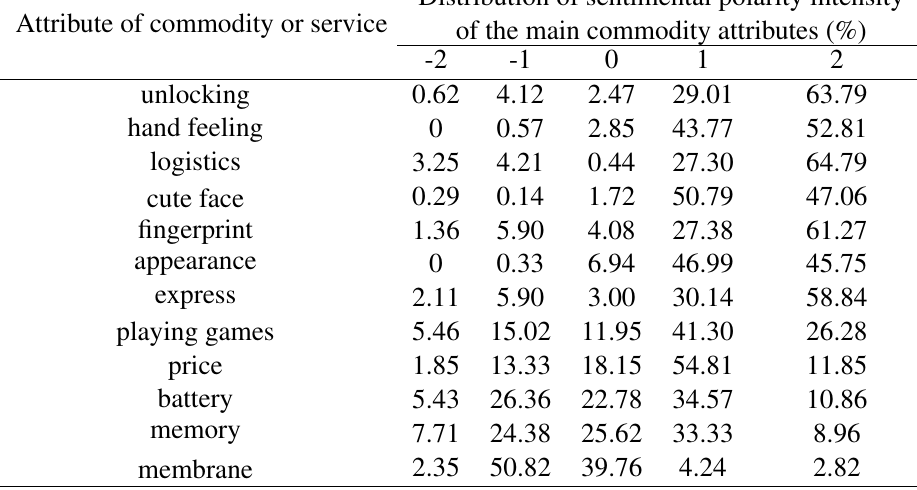
Table 4 The distribution of sentimental polarity intensity of the main commodity attributes Attribute of commodity or